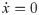
Stochastic models of gene expression with cell division.Arrows denote stochastic events that change the protein level by discrete jumps as shown in Eqs (1) and (4). The differential equation within the circle represents the time evolution of x(t) in between events. A) Model with all the different sources of noise: proteins are expressed in stochastic bursts, cell division occurs at random times, and molecules are partitioned between the two daughter cells based on Eq (5). The trivial dynamics x˙=0 signifies that the protein level is constant in-between stochastic events. B) Hybrid model where randomness in cell-division events is the only source of noise. Protein production is modeled deterministic through a differential equation and partitioning errors are absent, i.e., α = 0 in Eq (5). C) Hybrid model where noise comes from both cell-division events and partitioning errors. Protein production is considered to be deterministic as in Fig 2B. Since x(t) is continuous here, x+(ts) has a positively-valued continuous distribution with same mean and variance as in Eq (5)